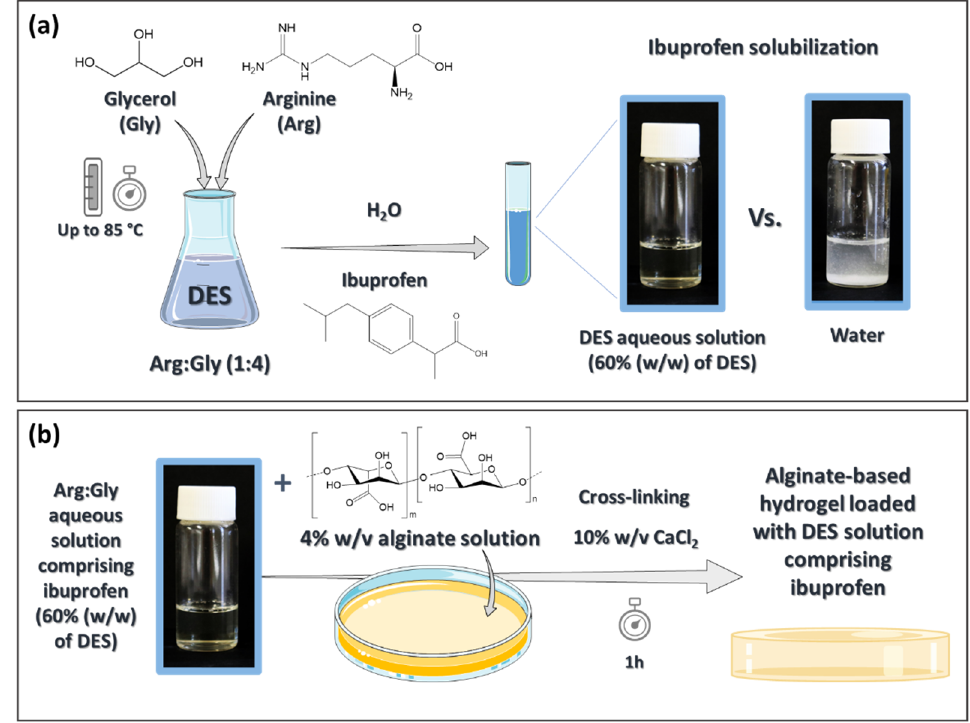
Figure 1. Schematic illustration of the preparation of a DES aqueous solution with higher solubilization ability for ibuprofen ( a ) and its incorporation in an alginate-based hydrogel ( b ) developed for the transdermal delivery of ibuprofen. Image made with Servier Medical Art and adapted by the authors according with Servier under the CC-BY 3.0 License (at https://smart.servier.com/, accessed on 23 January 2020).